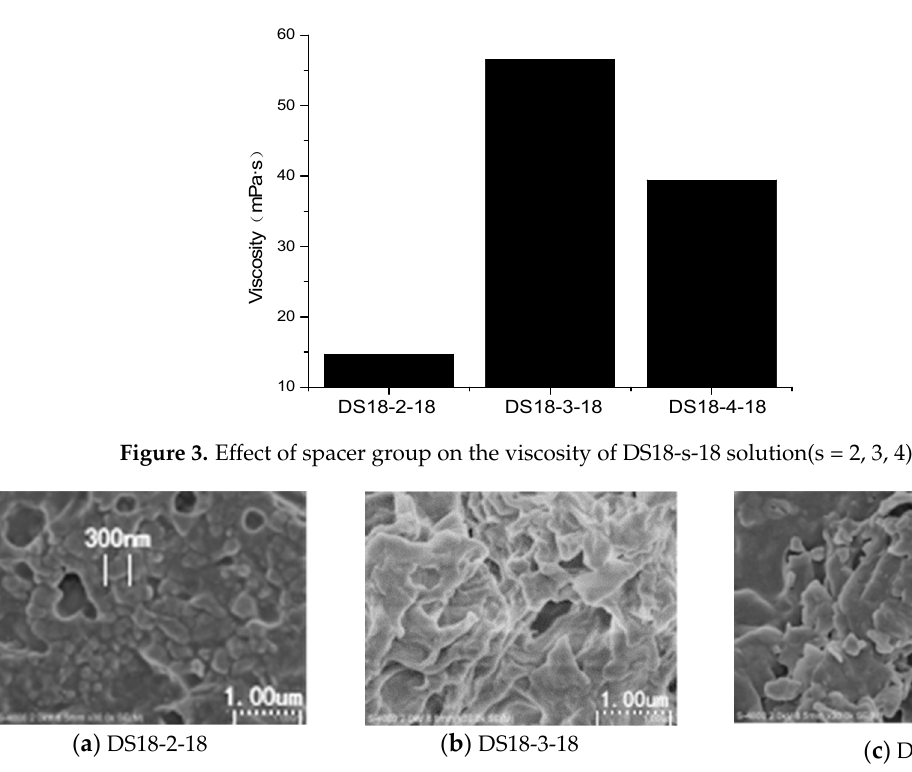
Figure 4. Effect of spacer group on micelle structure of DS18-s-18 solution(s = 2, 3, 4).